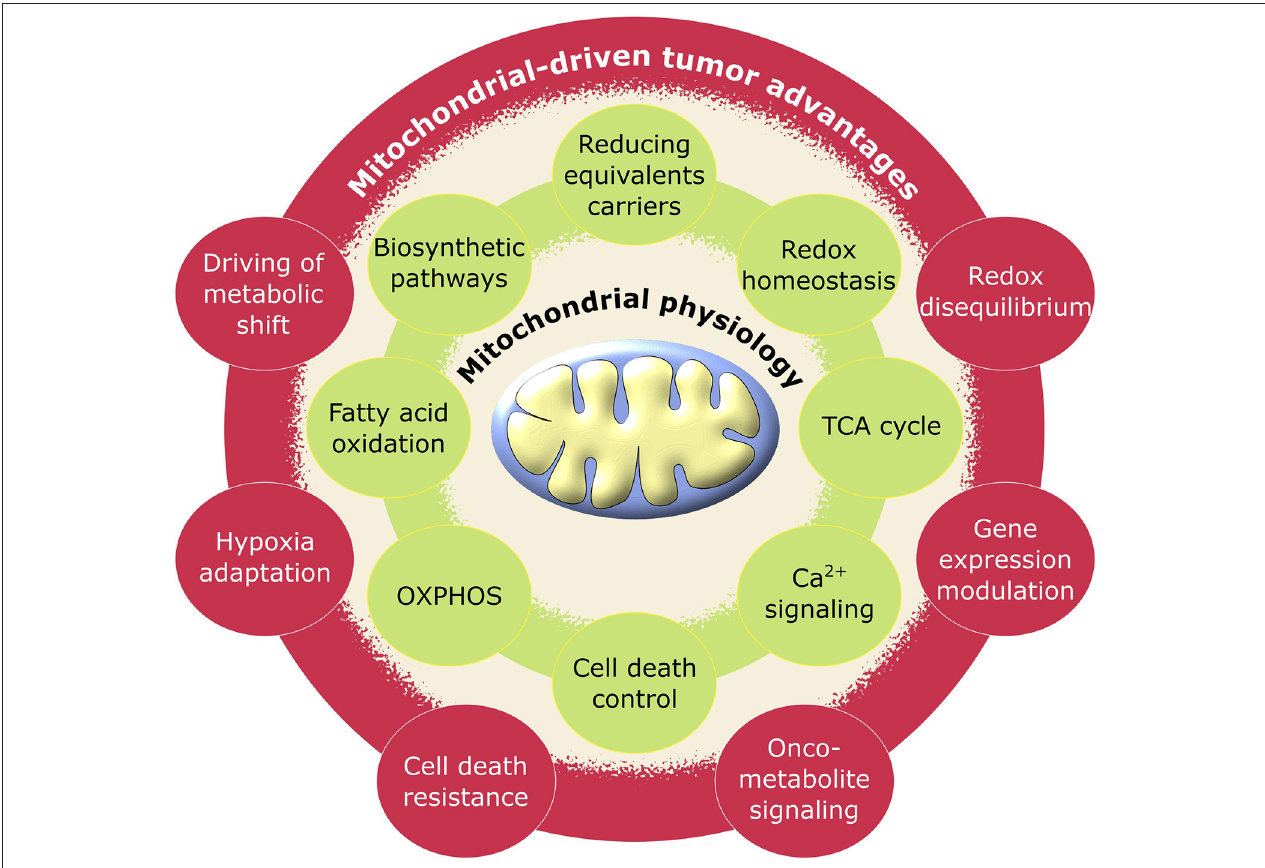
FIGURE 1 | Schematic representation of pro-tumoral biological processes regulated by mitochondria. Mitochondrial physiology (green) acquires advantageous alterations in cancer (red) adjusting its metabolic activity to support the requirements for neoplastic cell growth and